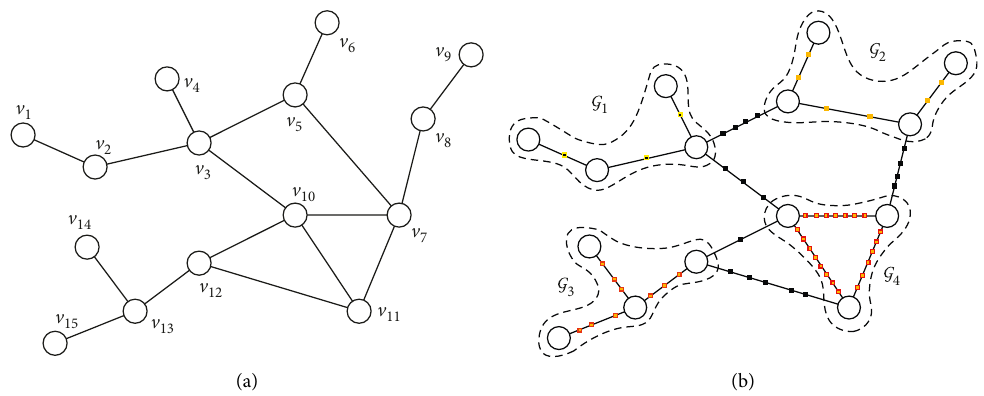
Figure 1: An example of the road network with trajectories. (a) A road network. (b) Regional